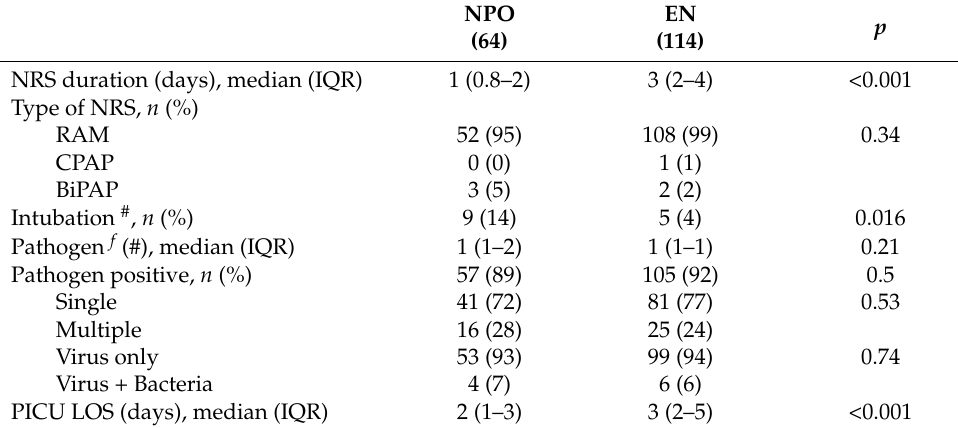
Table 2. Clinical Characteristics of Entire Cohort ( n =